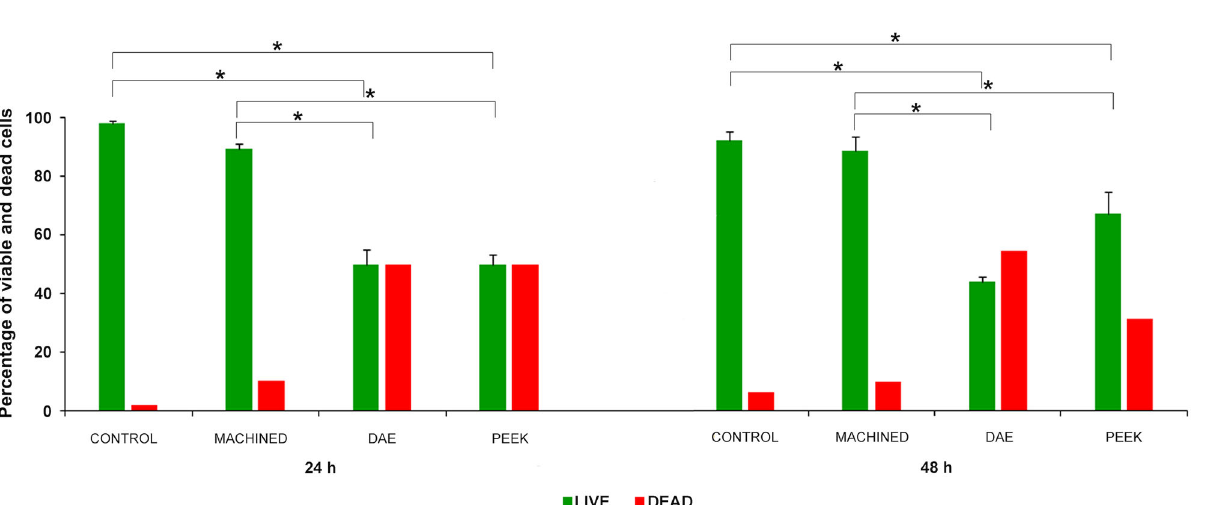
Fig. 8 Percentage of viable (green) and dead (red) cells in the formed bio fi lm on machined, DAE and PEEK with Live/Dead staining. All formed bio fi lms on different material surfaces were compared to the controls group that were the untreated samples obtained with the